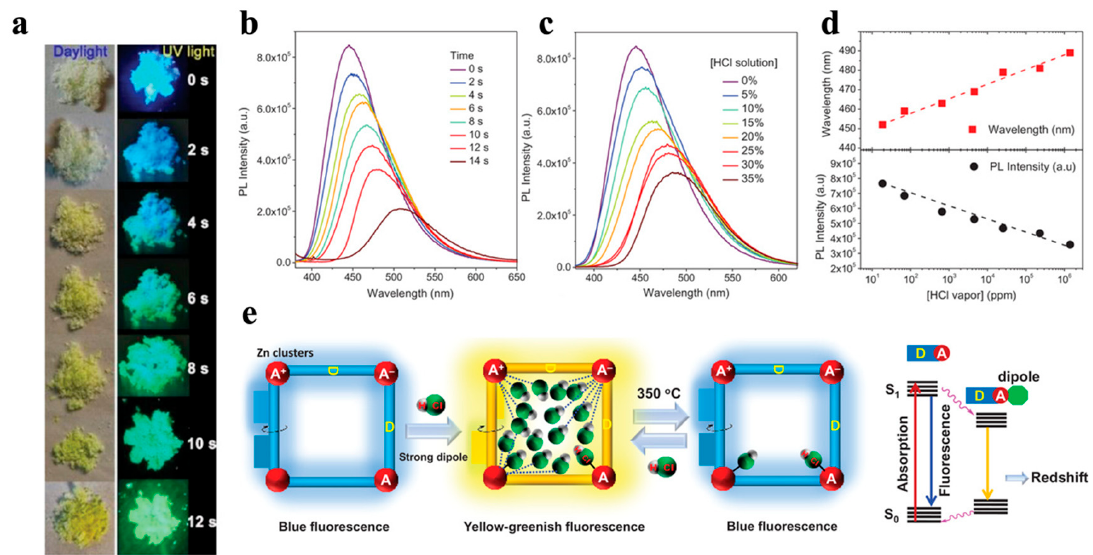
Figure 1. HCl vapor sensing by ZnMOF. ( a ) Photographs of ZnMOF fumigated with HCl vapor from 12% HCl solution. ( b ) Fumigation time dependence. ( c ) HCl solution concentration dependence (fumigation time = 5 s) of solid-state fluorescence spectra of HCl-vapor fumigated ZnMOF. ( d ) Emission peak and intensity responses to HCl vapor concentration. ( e ) Schematics showing the solid-state fluorescence change of ZnMOF with adsorption and desorption of HCl vapor (the blue dotted line for host–guest interaction, and the black solid line for coordination), and the energy diagram of ZnMOF showing the influence of dipole–dipole interaction [6]. Copyright 2021, John Wiley and Sons.